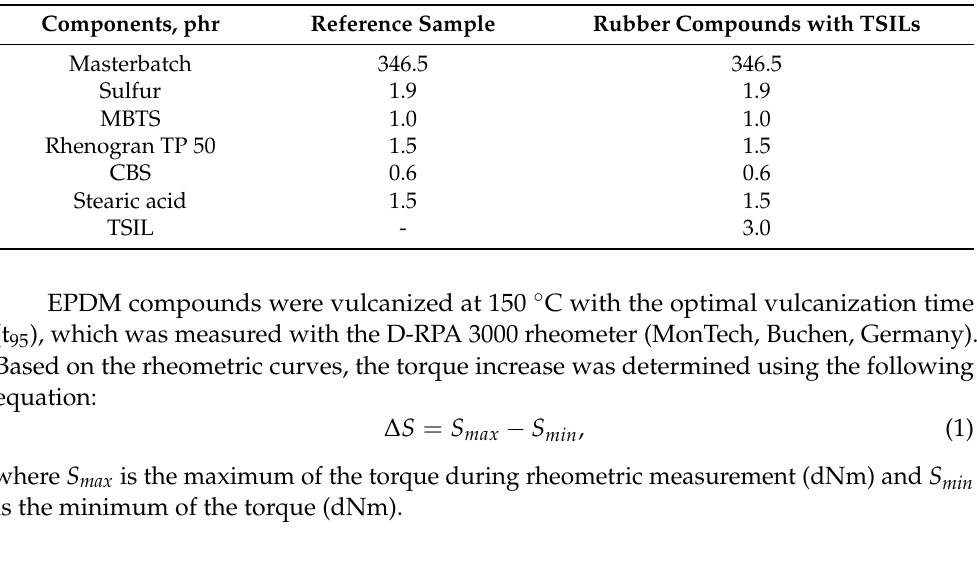
Table 2. General composition of EPDM compounds containing Ionic Liquids (ILs) (phr); (MBTS, benzothiazole disulfide; Rhenogran TP 50, zinc dialkylditiophosphate; CBS, N